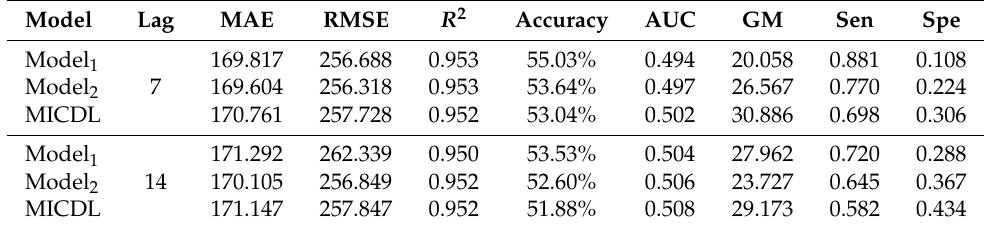
Table 4. Performance of the evaluated models for all BTC